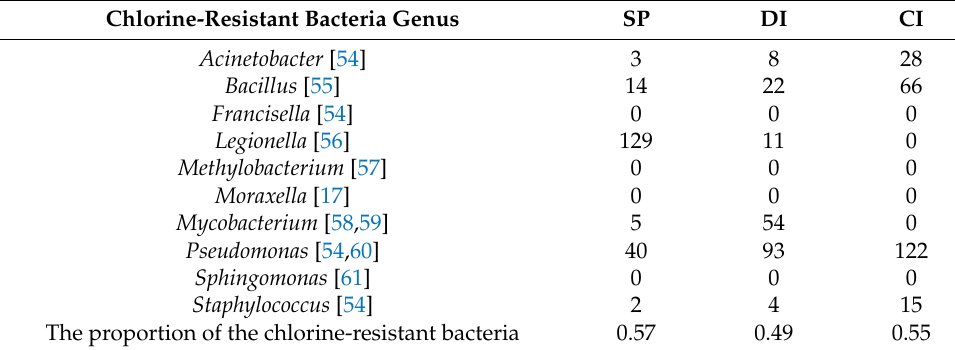
Table 5. Proportion of Chlorine-resistant bacteria genus.